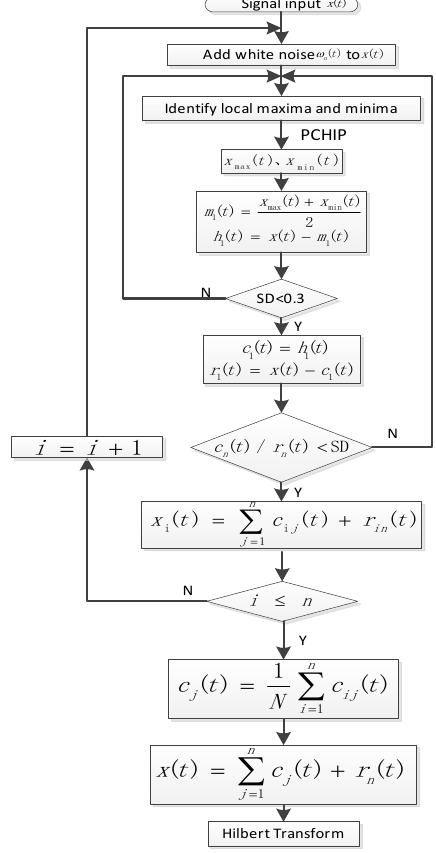
Figure 1. Improved EEMD algorithm flow chart.